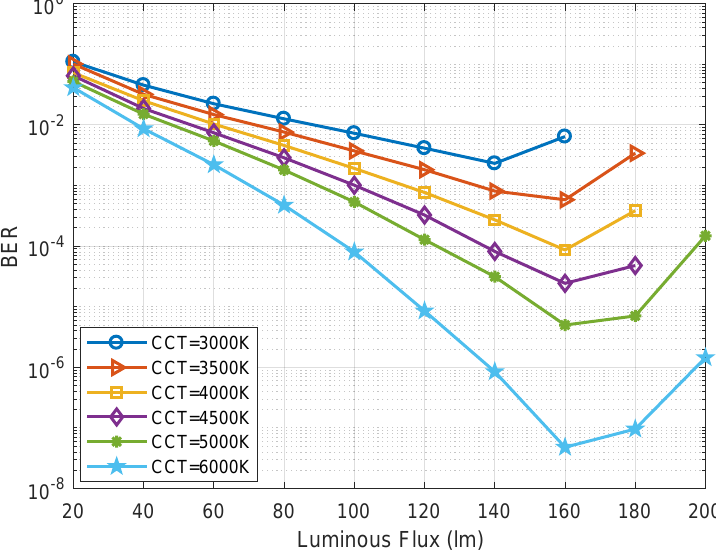
Figure 8. The BER performance of the proposed precoder for different CCT values when η =